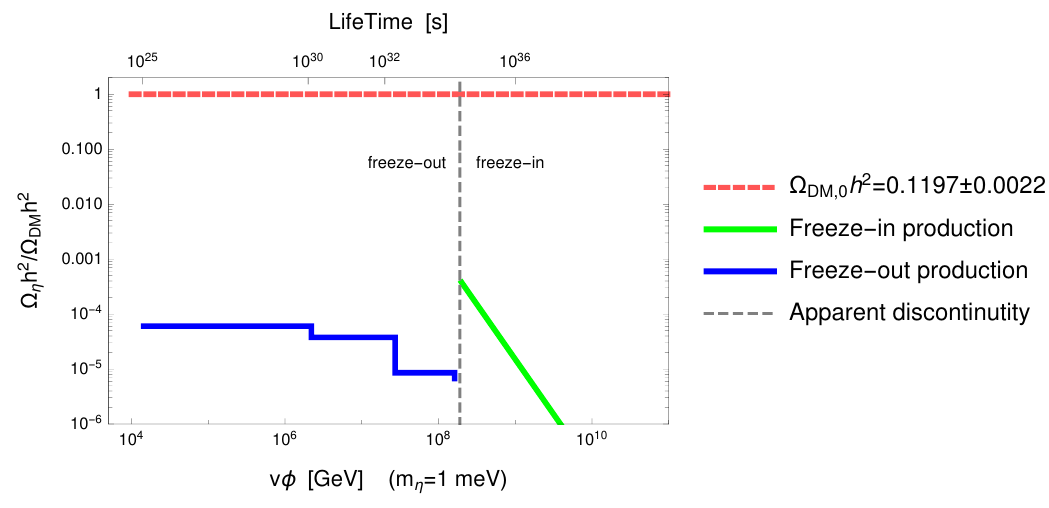
Figure 5 . Abundance of (cid:17) with respect to the (cid:13)avon vev and the lifetime of (cid:17) for m (cid:17) = 1 meV. The particle (cid:17) is produced through the freeze-out mechanism for v (cid:30) (cid:20) 1 : 622 (cid:2) 10 8 GeV, and through the freeze-in process for v (cid:30) > 1 : 622 (cid:2) 10 8